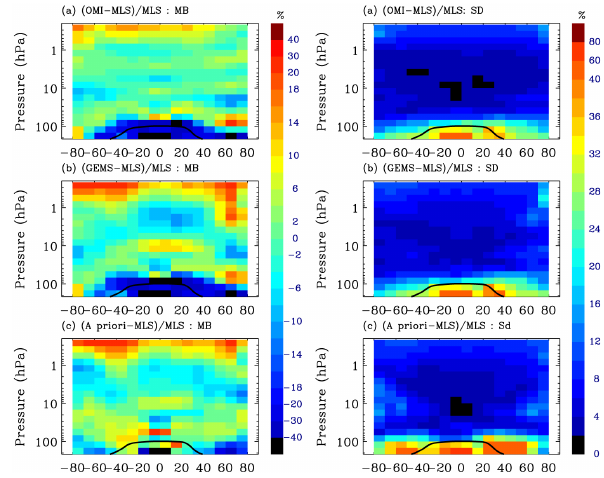
Fig. 3. Comparison of MLS ozone profile measurements with re- spect to (a) GEMS and (b) OMI retrievals for 10 ◦ latitude bins ( − 80 ◦ S–80 ◦ N) for April 2006. (c) The a priori (based on LLM cli- matology) used in the GEMS/OMI retrievals is also compared with MLS. Left and right panels show the mean biases (MB) and the 1 σ standard deviations (SD) of the relative differences as functions of MLS vertical layers (0.22–215hPa). The black line indicates the position of the mean tropopause during April